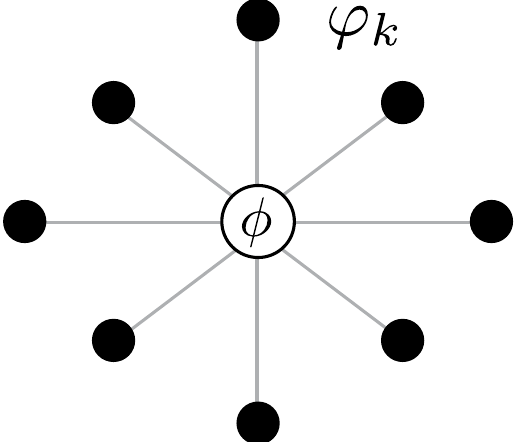
Figure 1. Configuration of a star network, where φ is a hub and ϕ k are leaf oscillators, k = 1 … N